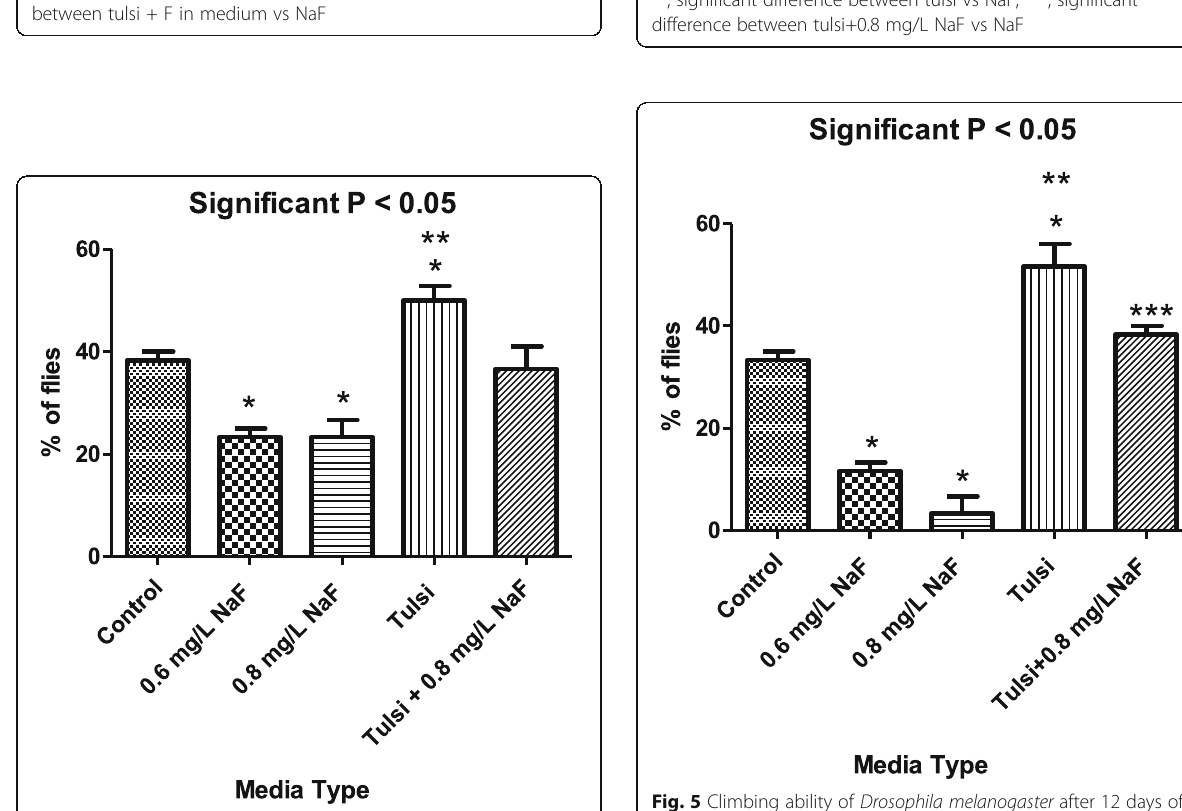
Fig. 4 Climbing ability of Drosophila melanogaster after 09 days of eclosion. *, significant difference between control vs NaF and tulsi;